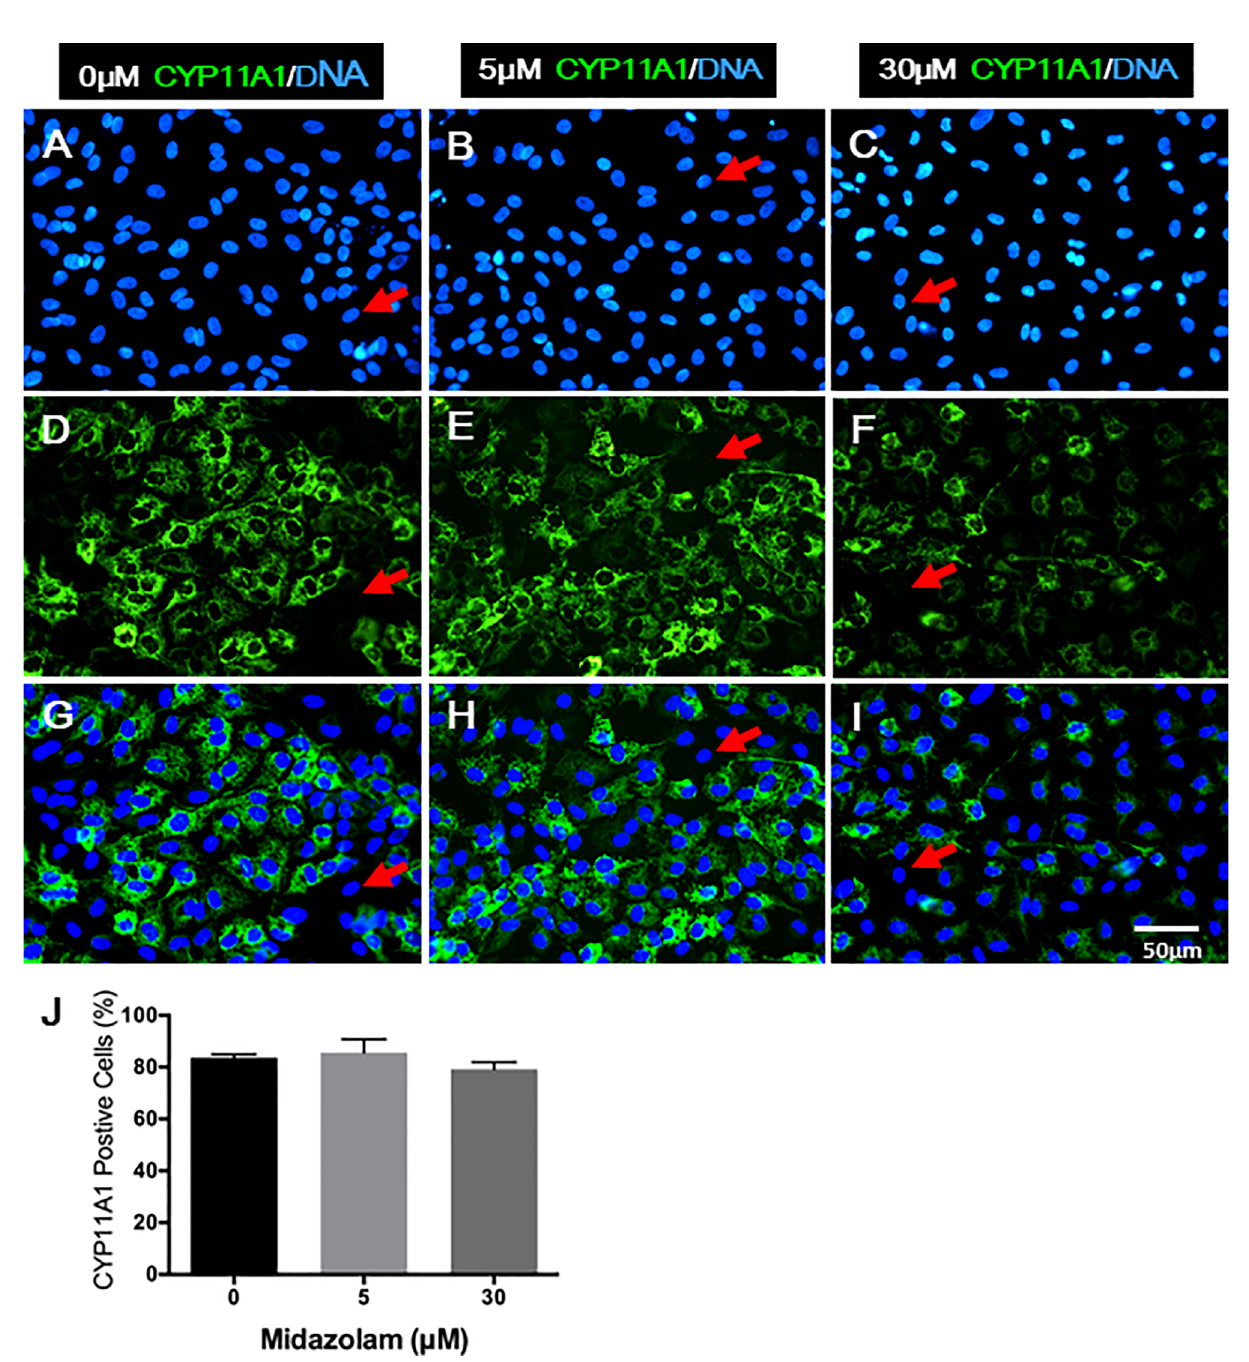
FIGURE 7 | Effects of midazolam on the differentiation of CYP11A1+ cells: stem Leydig cells were induced to differentiate into Leydig cells in the presence of 5 or 30 m M of midazolam for 21 days. CYP11A1 was stained by immuno fl uorescence (green). Nuclei were stained by DAPI (blue). Control (A, D, G) ; 5 m M of midazolam (B, E, H) ; 30 m M of midazolam (C, F, I) . (J) Quanti fi cation of CYP11A1+ cells from three doses. Photos are representatives of three experiments with similar results. Red arrows: examples of negative